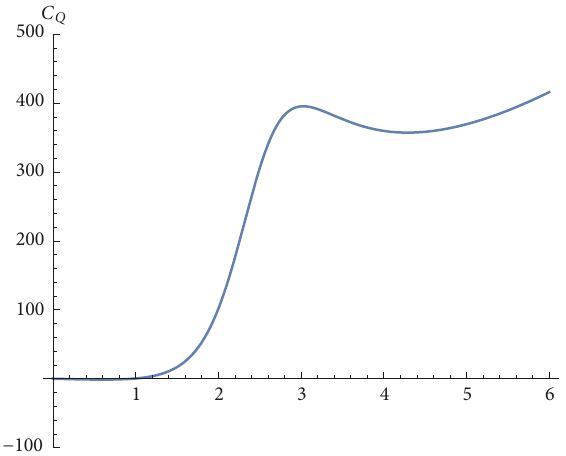
Figure 1: 𝐶 푄 −𝑟 + diagram of charged AdS black holes in the rainbow gravity. It corresponds to 𝑙 = 6 . We have set 𝑄 = 1 , 𝜂 = 1 , 𝑚 = 0 .